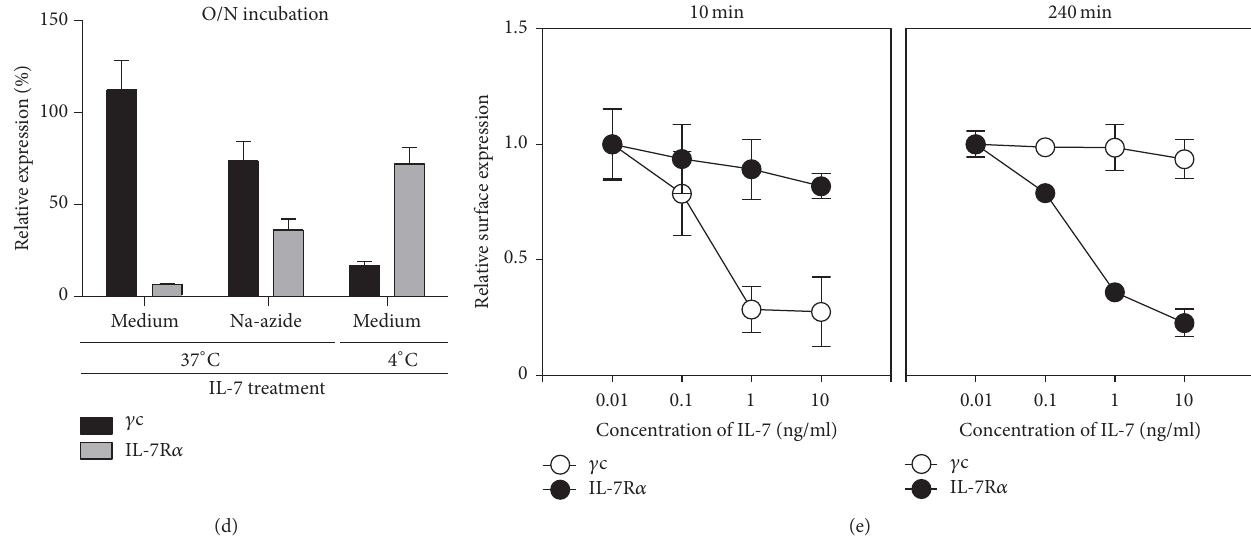
Figure 3: Energy-independent reduction of 𝛾 c surface expression. (a) T cells were stimulated in the presence of IL-7 plus sodium azide or vehicle, and the 𝛾 c (4G3) surface expression is analyzed by FACS. Data are summary of three independent experiments (mean and SEM). (b) T cells were stimulated in the presence of IL-7 at 4 ∘ C or 37 ∘ C, and the 𝛾 c surface expression is analyzed by FACS. Data are summary of three independent experiments (mean and SEM). (c) T cells were stimulated in the presence of IL-7 plus sodium azide or vehicle at 4 ∘ C or 37 ∘ C for 16 hours, and the 𝛾 c (4G3) surface expression is analyzed by FACS. The maximum value of 𝑥 -axis is 200 for 4 ∘ C and 37 ∘ C medium histograms and is 40 for sodium azide histogram. Histograms are representative of three independent experiments. (d) Relationship between IL-7R 𝛼 downregulation and 𝛾 c expression. Relative expression was calculated as the Δ MFI associated with IL-7 treated group at the indicated condition over the Δ MFI associated with medium control group at the relevant condition. Data are summary of three independent experiments (mean and SEM). (e) Kinetics of 𝛾 c (4G3) surface level upon short-term (10 minutes) and long-term (240 minutes) stimulation with different concentration of IL-7. T cells were stimulated with an indicated concentration of IL-7 for 10 and 240 minutes, and the surface 𝛾 c and IL-7R 𝛼 expression were analyzed by FACS. Data are summary of three independent experiments (mean and